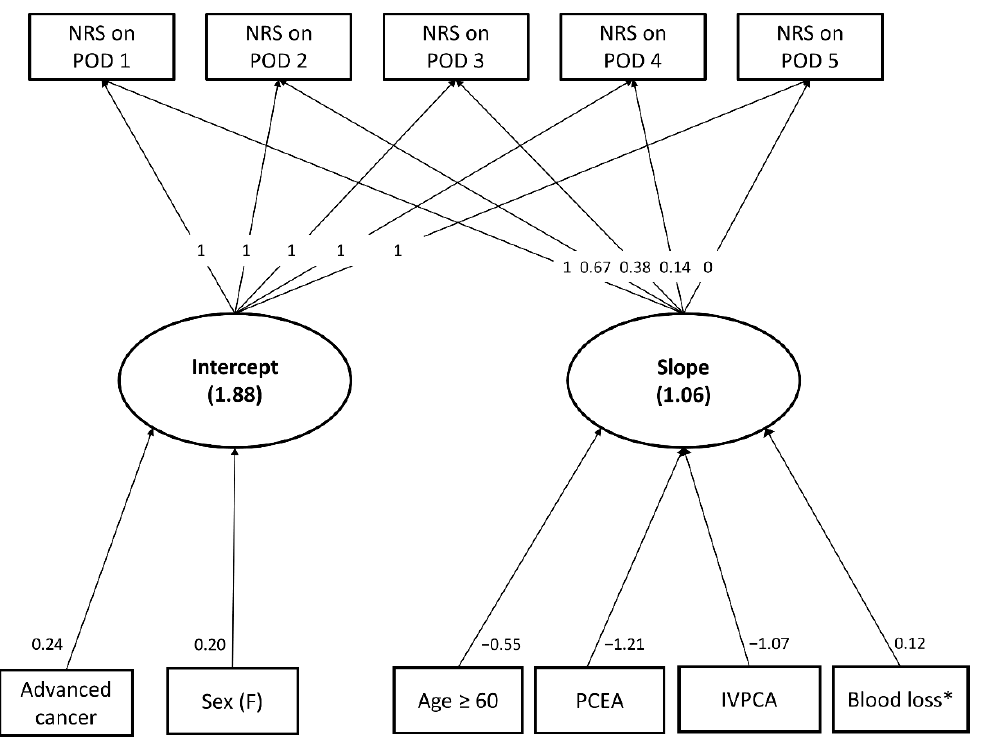
Figure 3. The final predictive model for pain trajectories after surgery for renal cell carcinoma.* On base-2 logarithmic